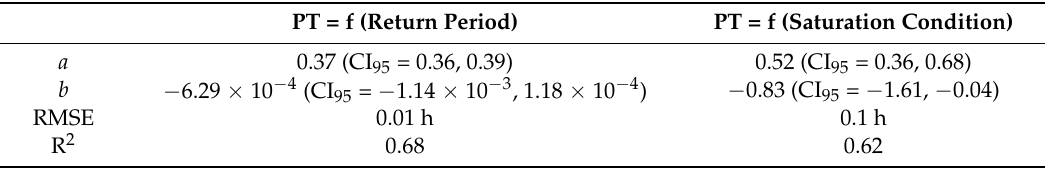
Table 3. Fitted coefficients, 95% confidence intervals (CI 95 ) and goodness of fit (R 2 and Root Mean Square Error—RMSE) for Equation (4) when considering the ponding time (PT) as a function of the return period or the saturation condition.